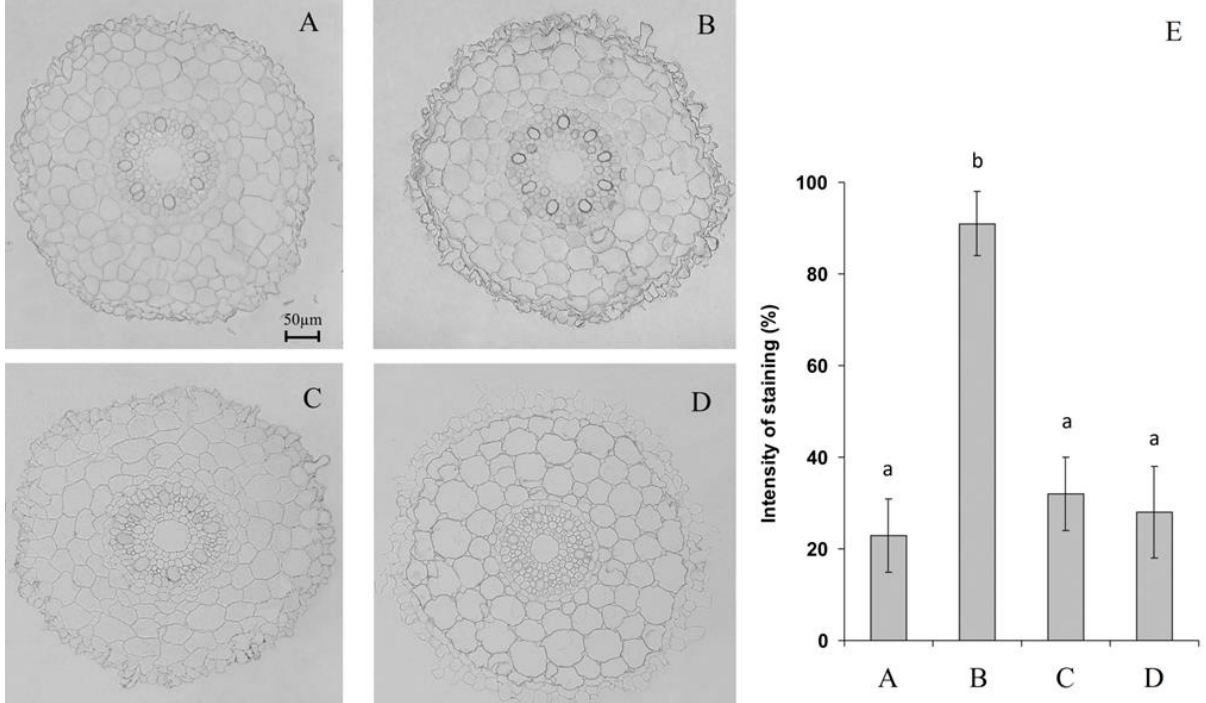
Figure 3. Immunolocalization of PIP2;2 aquaporins ( A – D ) and intensity of staining for PIP2;2 aquaporins ( E ) (means ± SE, arbitrary units, maximal staining taken as 100%, minimal as 0%) in root sections untreated ( A ), treated with 10 μM ABA ( B ) and its combination with 10 μM diphenylene iodonium chloride ( C ) and 10 mM ascorbic acid ( D ). Data represent the mean ± S.E. ( n = 50) of arbitrary units; maximal staining was taken for 100%, and minimal staining was 0%. Significantly different means for each variable are labelled with different letters ( p ≤ 0.05, LSD test).